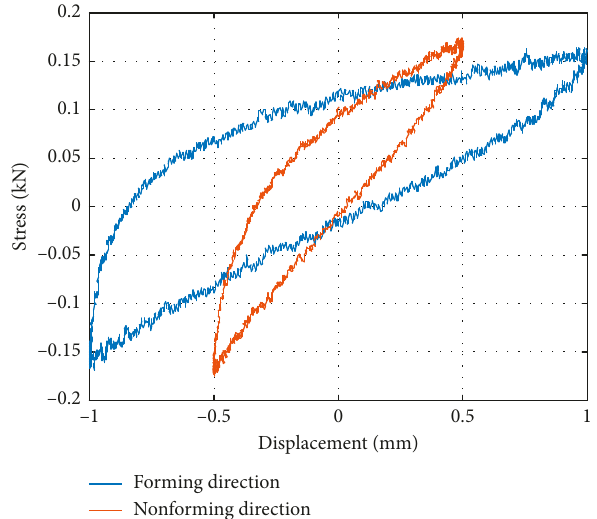
Figure 2: Hysteresis loop of MR in the forming/nonforming